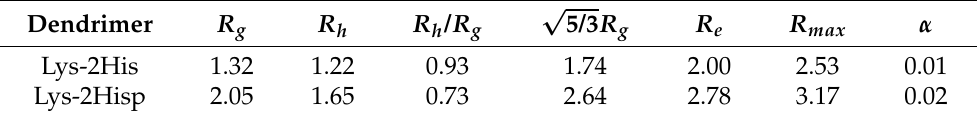
Table 2. The global characteristics of the Lys-2His and Lys-2Hisp dendrimers averaged through whole trajectory time: the radius of gyration R g (nm), the hydrodynamic radius R h (nm), the ratio √ R h / R g , the rigid-sphere approximation 5/3 R g (nm), the position of terminal groups R e (nm), the effective radius R max (nm) (see subsection “Electrostatic interactions”) and shape anisotropy α at temperature 310 K.